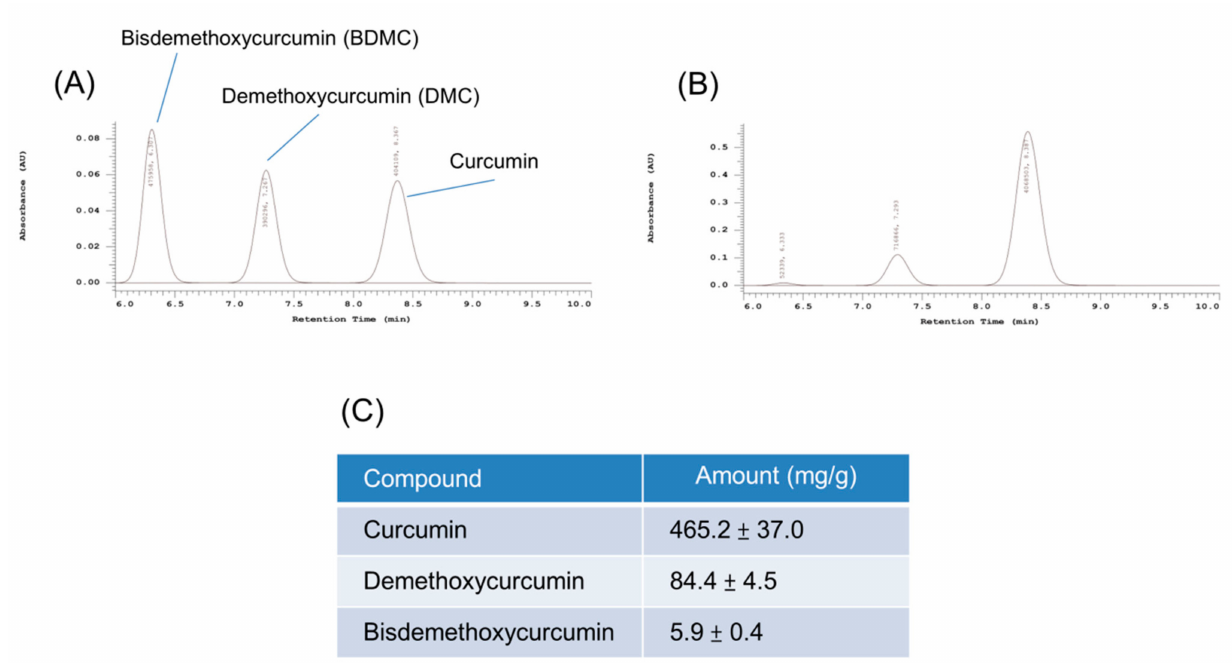
Figure 2. Quantitative analysis of curcumin, demethoxycurcumin (DMC), and bisdemethoxycurcumin (BDMC) in turmeric extract (BCM-95): ( A ) the HPLC chromatogram of the standards of three curcuminoids; ( B ) the HPLC chromatogram of three curcuminoids in turmeric extract; and ( C ) the amount (mg/g) of three curcuminoids in turmeric extract. All data are presented as the mean of three experiments ±